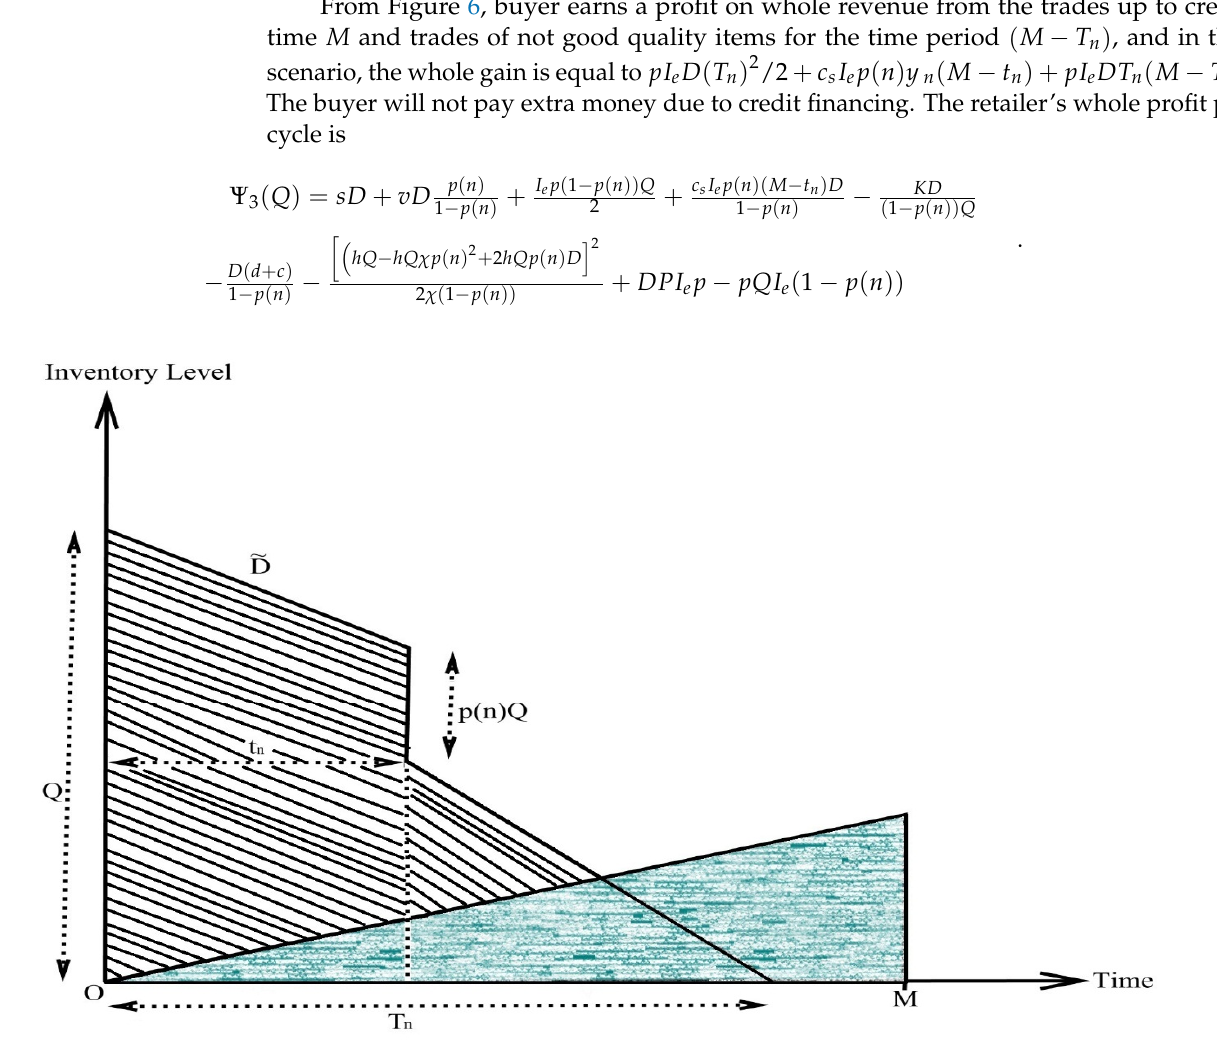
Figure 6. Inventory with time for Scenario-3.